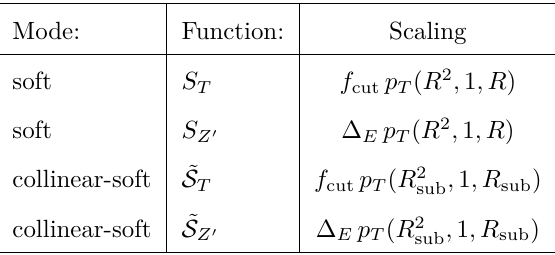
Table 4 . The parametric scaling of the momenta of the various modes in SCET, needed to describe the jet energy drop cross section for trimming with ∆ E (cid:28) f cut (cid:28) 1 and θ t = R sub /R (cid:28) 1 . These functions are similar to the ones for soft drop, as they can be obtained by appro- priately replacing trimming parameters by soft drop parameters. For example, ˜ S be obtained from eq. (3.20) by replacing θ